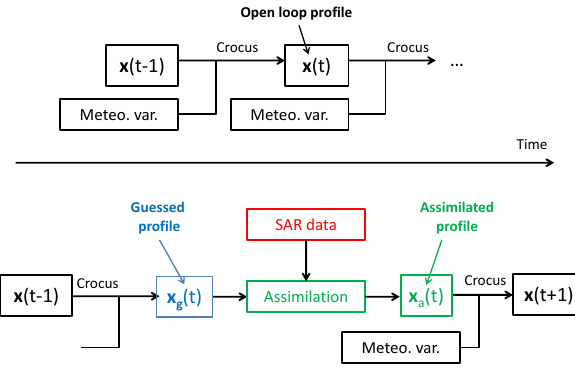
Figure 8. Implementation of SAR data assimilation in the Crocus temporal simulation of a snowpack.